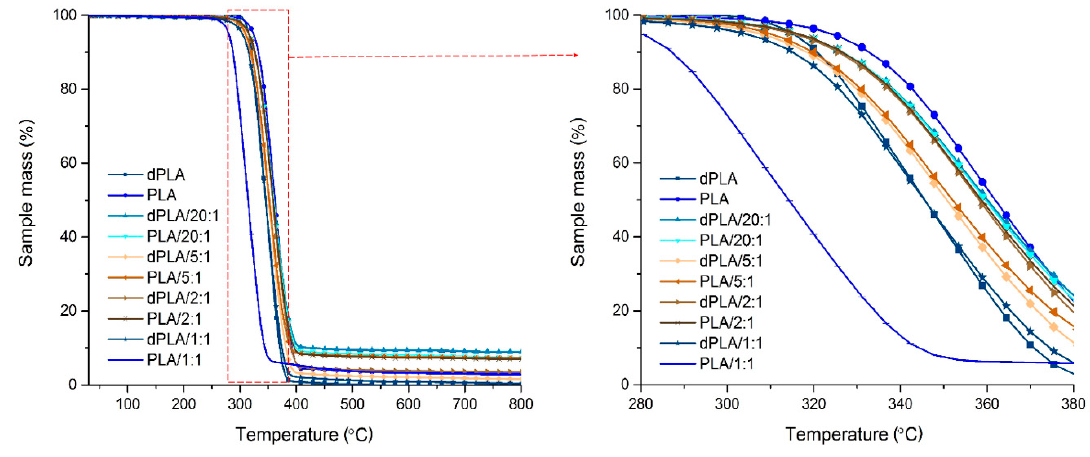
Figure 3. Curves for PLA-based films.